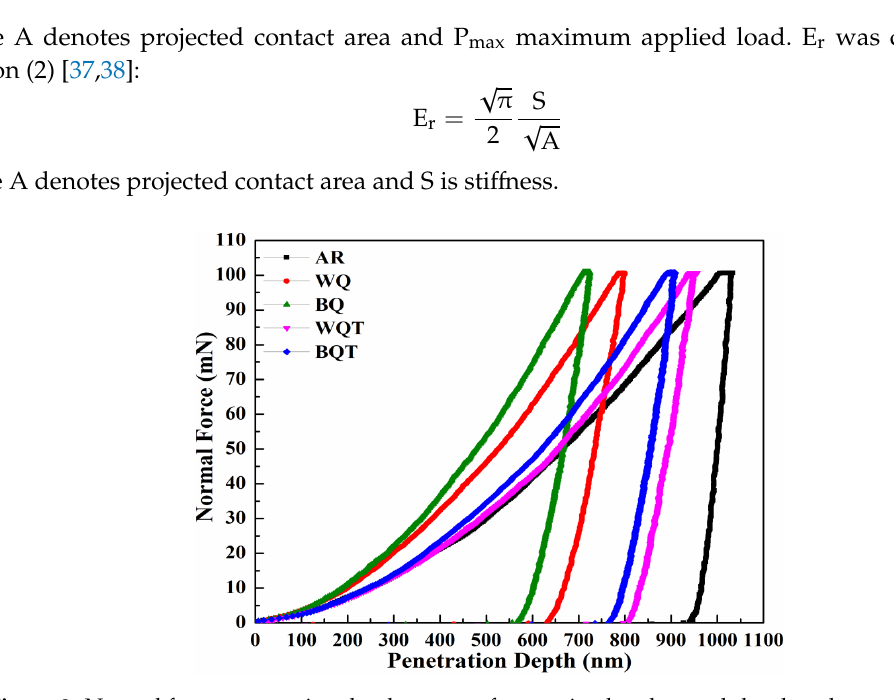
Figure 3. Normal force-penetration depth curves of as-received and quench-hardened, tempered low-carbon steel.